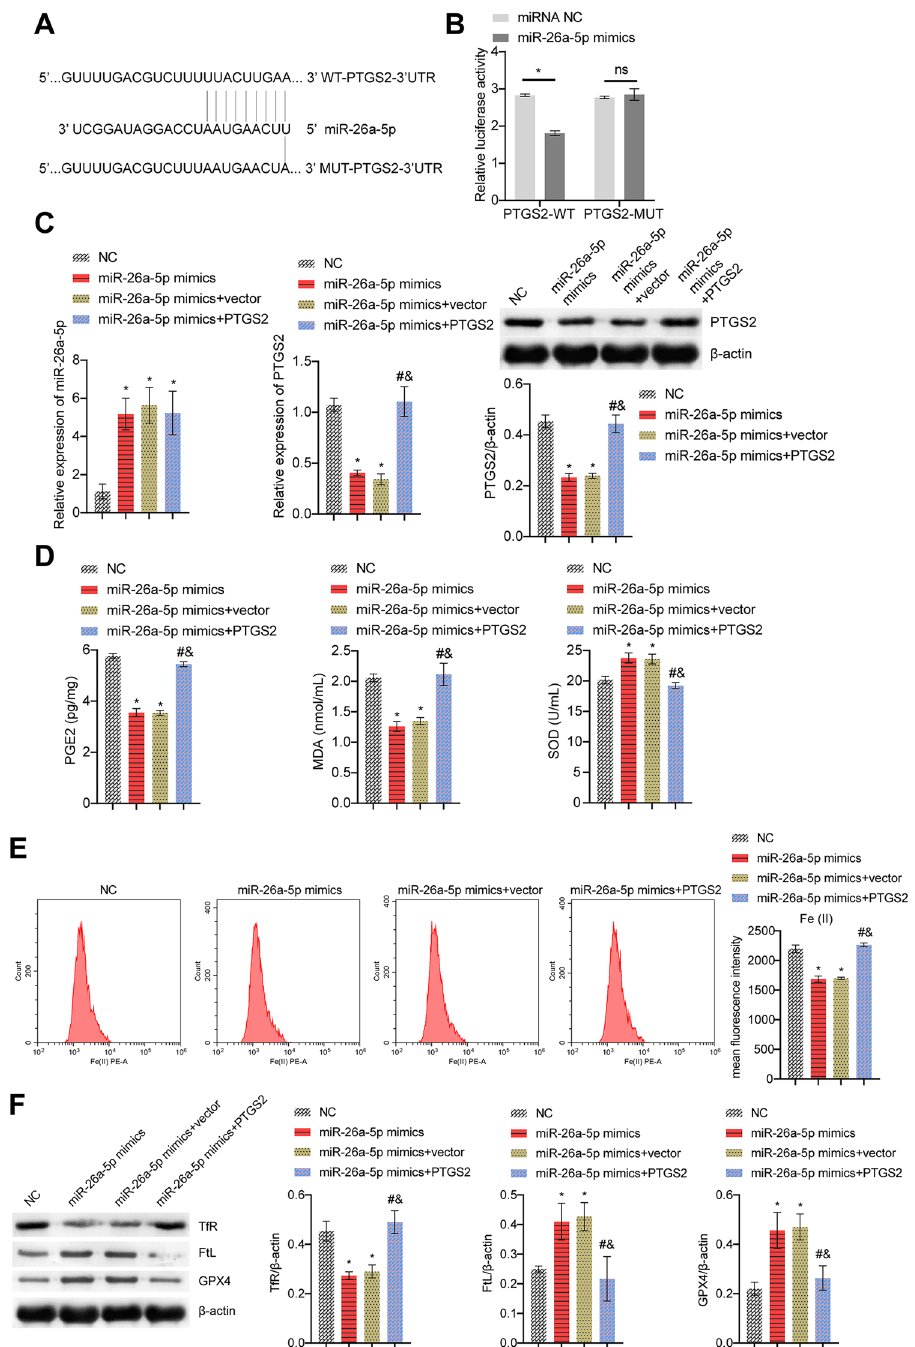
Figure 6. miR-26a-5p targeting PTGS2 affected CSE-induced ferroptosis in BECs. ( A ) Targeting sequences of miR-26a-5p and PTGS2. ( B ) Dual-luciferase verification of miR-26a-5p and PTGS2 relationship. ( C ) miR-26a-5p and PTGS2 mRNA expression, and PTGS2 protein expression. ( D ) ELISA detection of PGE2, lipid peroxidation MDA and SOD. ( E ) The content of catalytic Fe (II) was evaluated by FCM. ( F ) The protein expression of ferroptosis markers TfR, FtL, and GPX4. *P < 0.05 vs. NC, #P < 0.05 vs. miR-26a-5p mimics, &P < 0.05 vs. miR-26a-5p mimics + vector. The data were presented in the form of mean ± standard deviation. n =